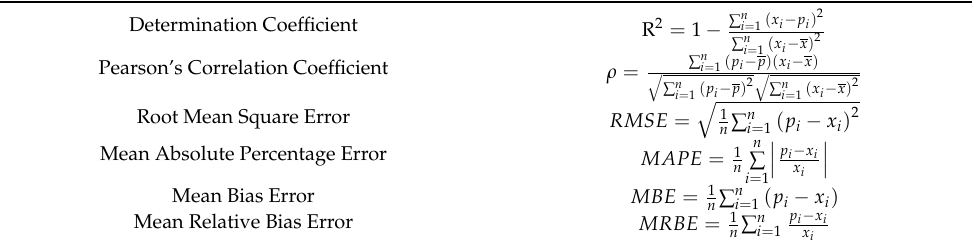
Table A1. Basic statistical evaluations used for the assessment of the IDNN performance. Determination